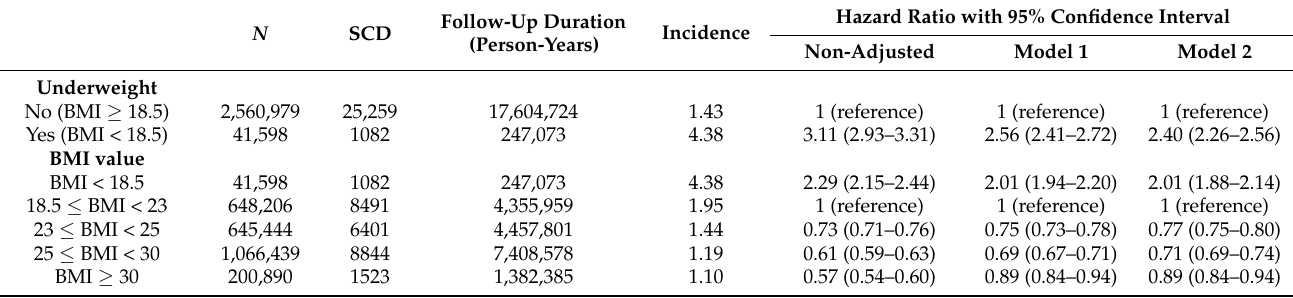
Table 2. Impact of underweight on SCD in DM patients.